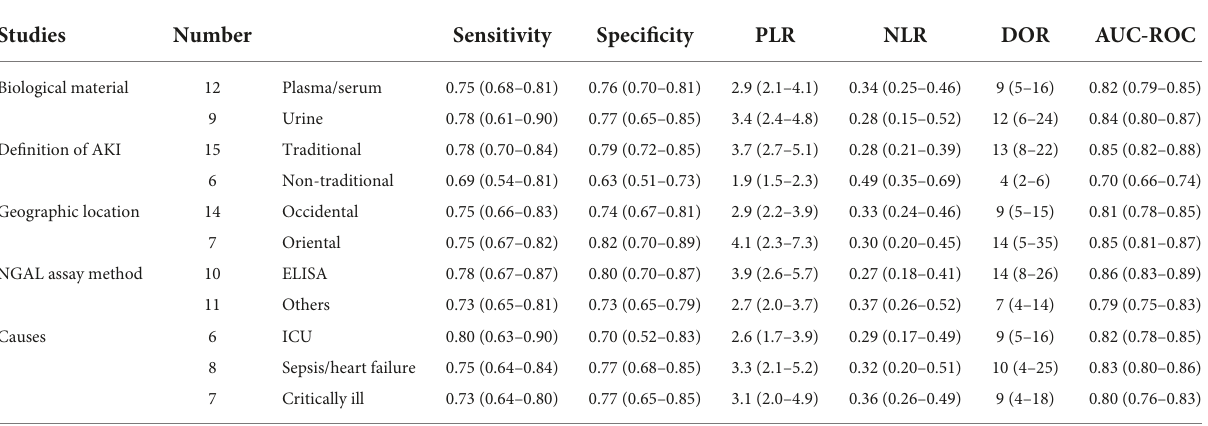
TABLE 3 Subgroup analysis on the basis of different